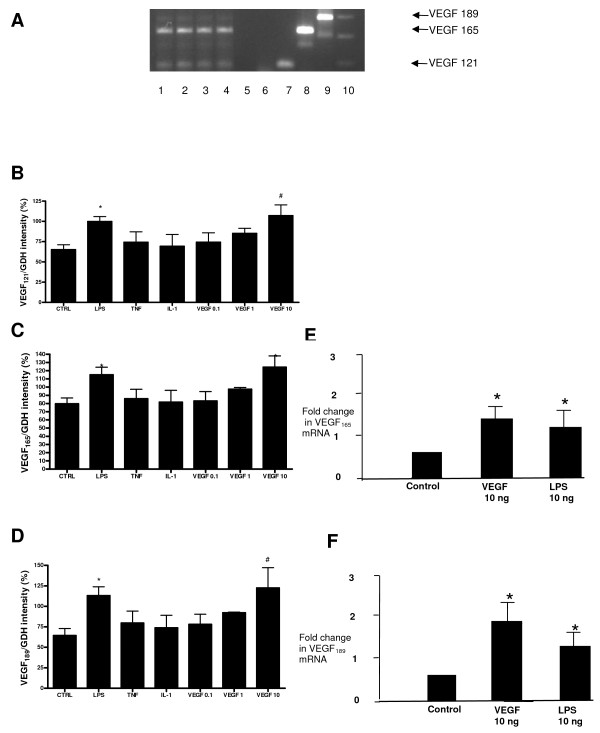
A) Representative RT-PCR gel of VEGF isoforms in ATII cells. Lanes are as follows: (1–4) human ATII cell samples, (5) blank, (6) negative control, (7–9) sequenced positive controls for VEGF121, VEGF165 and VEGF189 respectively, (10) 100 kb ladder (bottom marker denotes 100 bp, top marker denotes 300 bp). B-D): Semiquantitative densitometry data (n = 8, in triplicate) showing VEGF121, VEGF165and VEGF189 in response to LPS (10 μg/ml), TNF-α (10 ng/ml), IL-1β, VEGF165 (0.1,1,10 ng/ml) at 4 hours. Data are plotted as mean with bars denoting standard error. *P < 0.05 (ANOVA post hoc Bonferroni) 10 μg/ml LPS versus control (all isoforms) and 10 ng/ml VEGF165 versus control (VEGF165 only). #P < 0.01 (ANOVA, post hoc Bonferroni) 10 ng/ml VEGF versus control (VEGF121 and VEGF189). E-F): Further real-time PCR analysis confirmed the effect of LPS and VEGF on VEGF165 and VEGF189 (*p < 0.05 fold change compared to control).